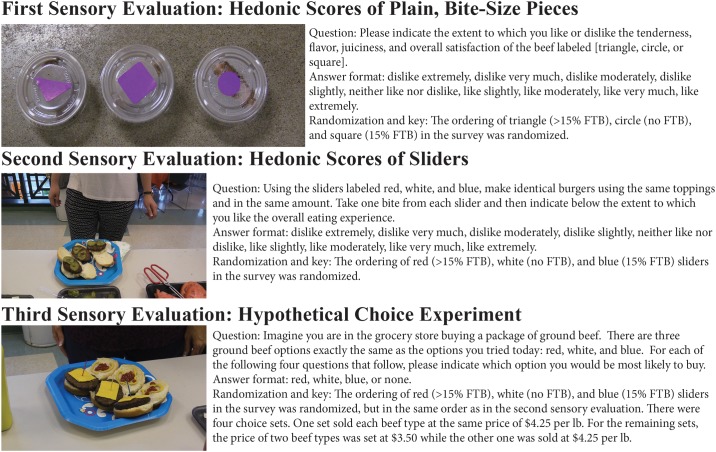
Illustration of three sensory evaluations.